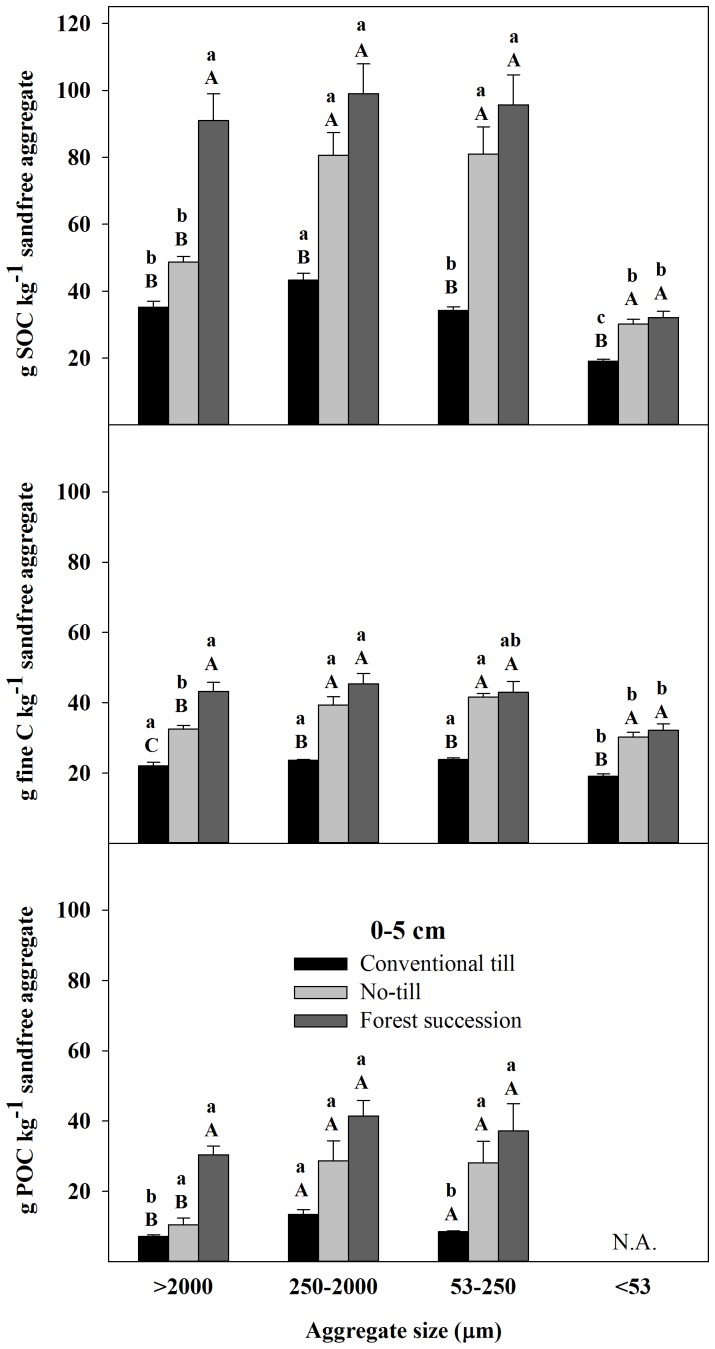
Total soil organic C (SOC), fine C (<53 µm), and particulate organic C (POC) (53–2000 µm) concentrations on a sand-free basis from 0–5 cm in four different aggregate size fractions (mean ±1 SE) in the Horseshoe Bend Agroecosystem Experiment (n = 4) Athens, GA, USA, October 2007.Different uppercase letters within an aggregate size class and C fraction represent a significant difference between land uses. Different lowercase letters within a C fraction and a land use represent a significant difference among aggregates size classes (α = 0.05). See also Table S3, part 1 and Table S3, part 2.